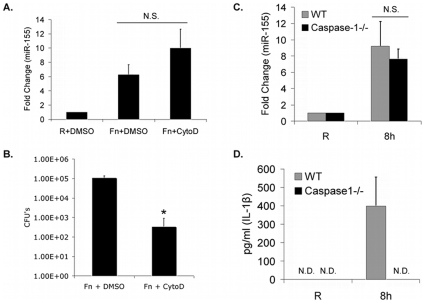
Effects of host-cell entry and inflammasome activation on miR-155 induction.(A) PBM were pretreated for 30 minutes with 5 µg/ml cytochalasin D (CytoD), infected with F.n. at an MOI of 50 for 6 hours, then relative miR-155 expression measured by qRT-PCR. (B) CFU assays were conducted in parallel with the samples from Figure 4A. (C) Wild-type (WT) and caspase-1−/− bone marrow-derived macrophages were infected with F.n. at an MOI of 50 for 8 hours and miR-155 was assayed by qRT-PCR. (D) ELISAs were done to measure IL-1β in supernatants from the samples in Figure 4C. Graphs represent the mean and standard deviation from three independent infections. Data were analyzed by a paired Student t test. An asterisk (*) indicates a p-value<0.05.